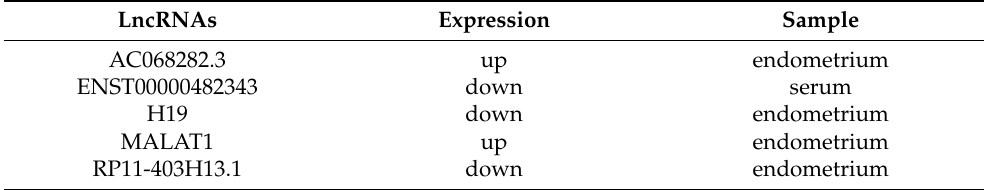
Table 3. lncRNAs expressed in different samples on patients with endometriosis. LncRNAs Expression Sample AC068282.3 up endometrium ENST00000482343 down serum H19 down endometrium MALAT1 up endometrium RP11-403H13.1 down